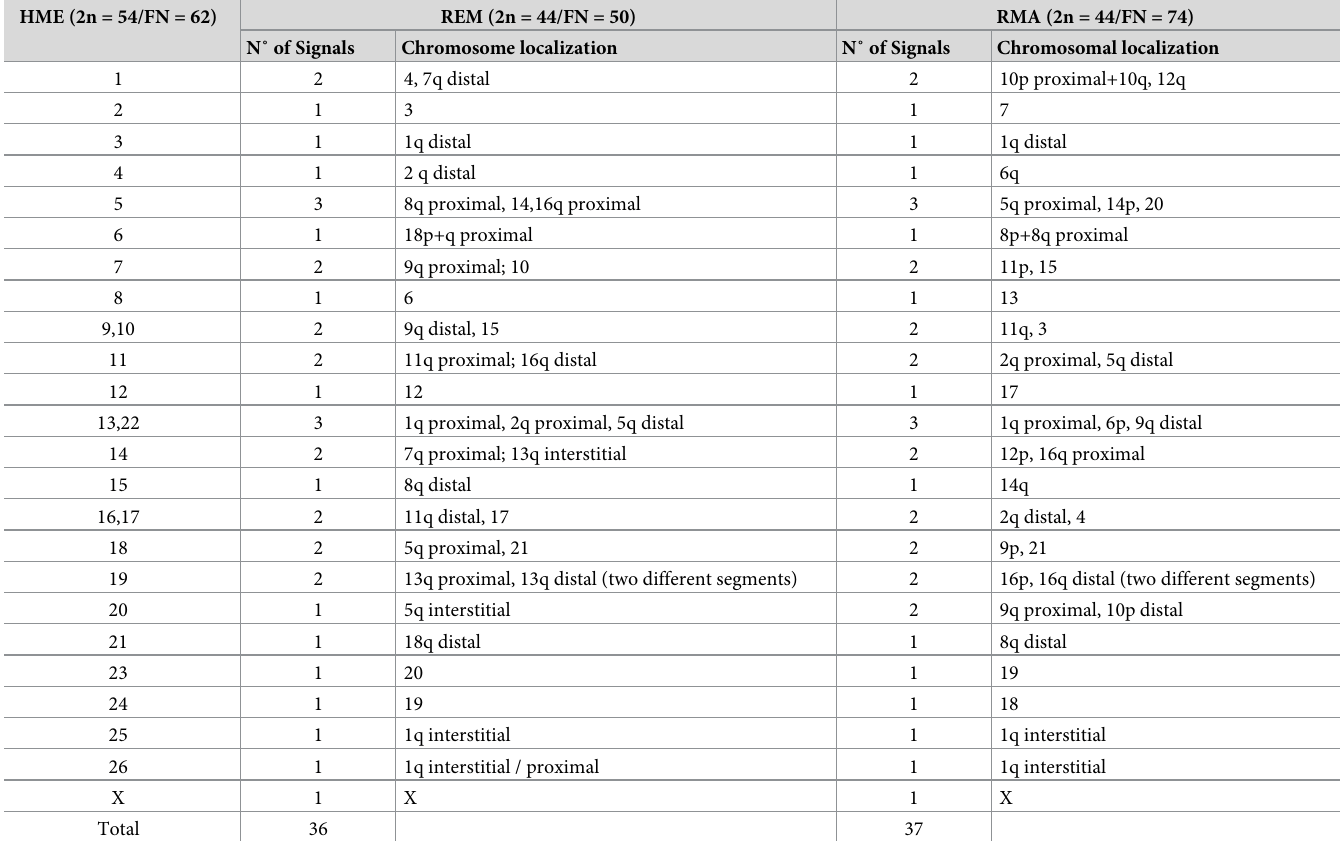
p = short arm; q = long arm.